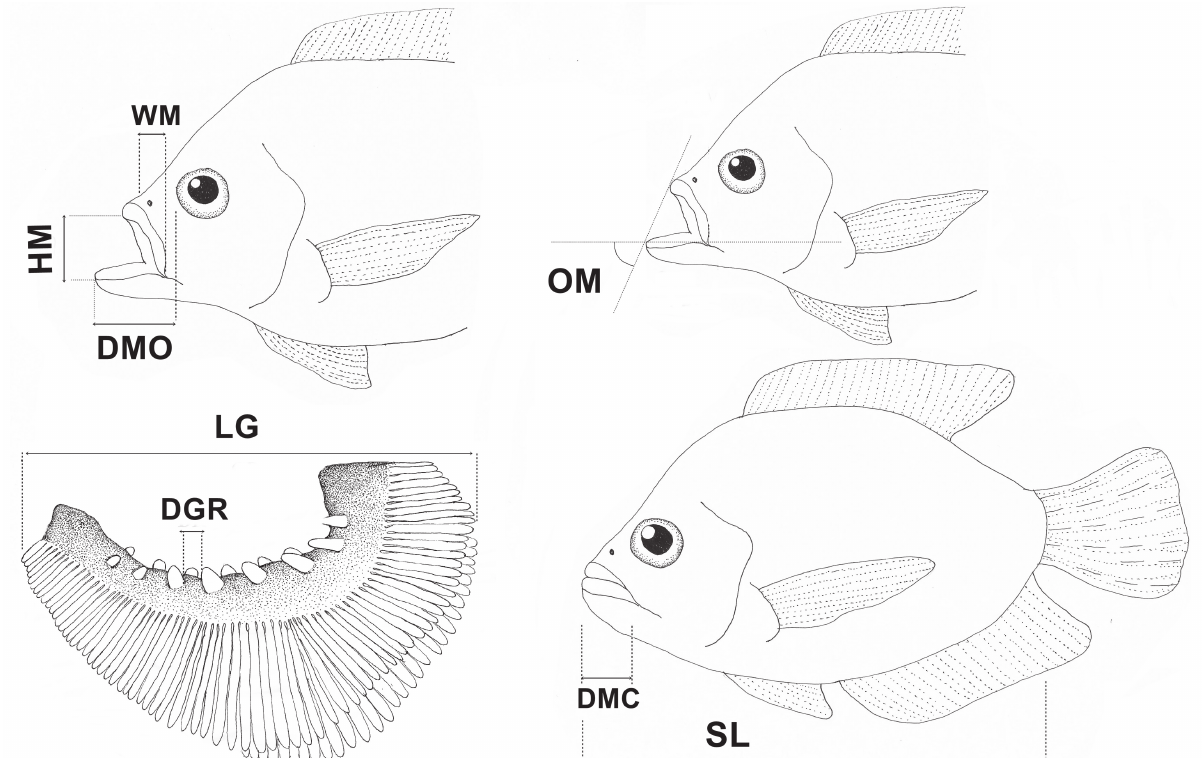
Fig. 2. Representation of ecomorphological measurements taken for four species of cichlids of the Cuiabá River basin, Mato Grosso, Brazil. OM = orientation of the mouth opening; HM = height of the mouth; WM = width of the mouth; DMO = distance from the anterior end of the jaw to anterior border of the eye, with the mouth open; DMC = distance from the end of the jaw to anterior border of the eye, with the mouth closed; LG = length of the gi ll ; DGR = distance between the gill rakers; SL = standard